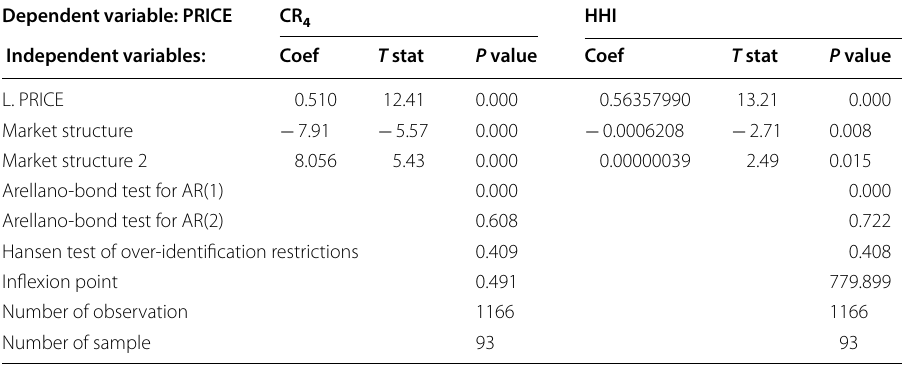
Table 4 Regression result for market structure—price relation. Source: Author’s calculation on data provided by the Indonesia Financial Services Authority Dependent variable: PRICE CR 4 HHI Independent variables: Coef T stat P value Coef L. PRICE